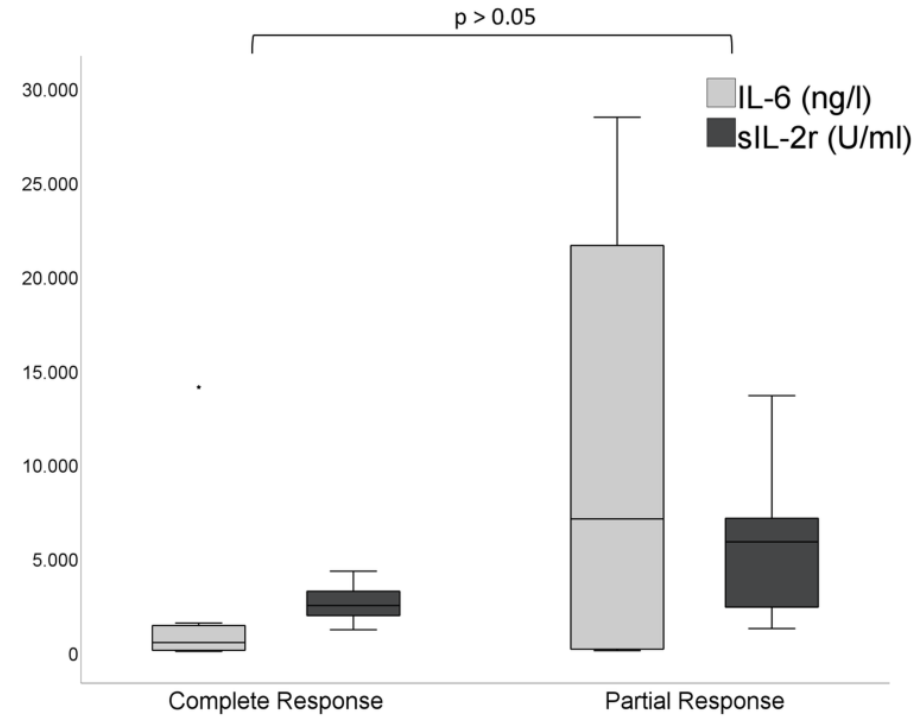
Figure 5. IL-6 peak (867 ± 951 ng/L vs. 9121 ± 11,266 ng/L) and IL-2R peak (2483 ± 1164 U/mL vs. 5548 ± 3949 U/mL) in patients with CR vs. PR ( p > 0.05).